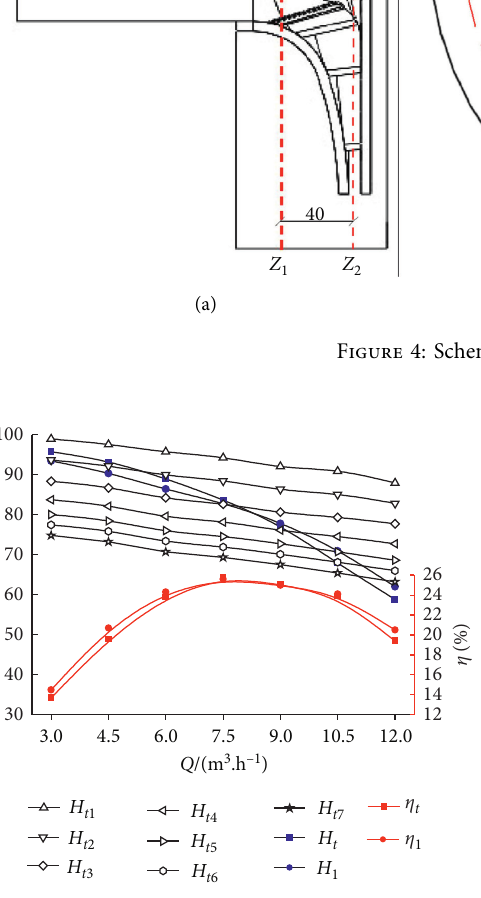
Figure 5: Internal pressure and performance curve.